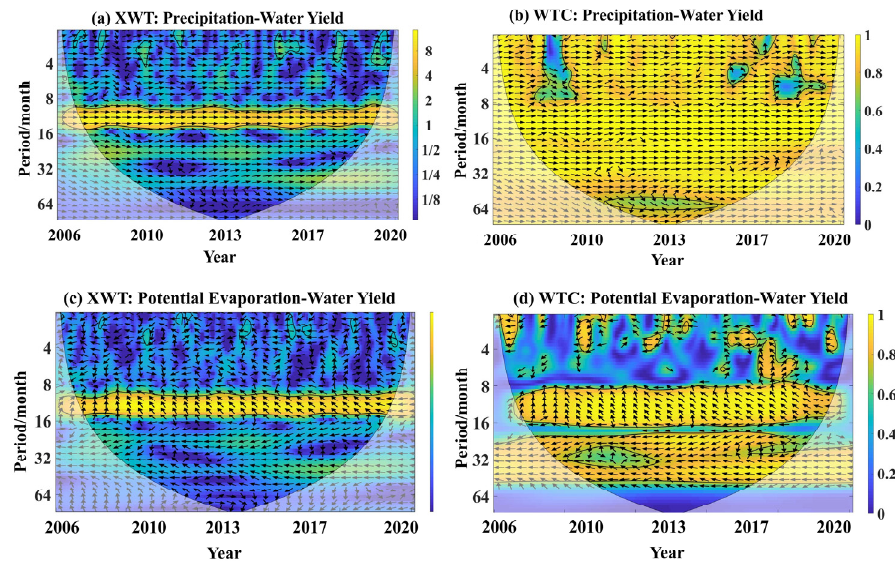
Figure 8. Cross-Wavelet Results for Precipitation, Potential Evapotranspiration and Water Yield in the XRB. Table 8. The correlationanalysisandstatisticsforwateryield, precipitationandpotentialevapotranspiration.